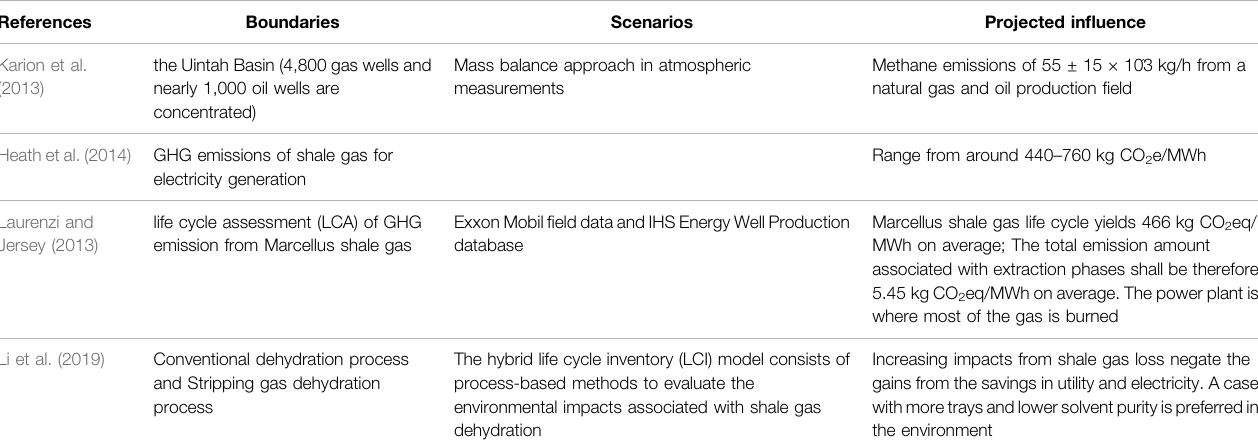
TABLE 2 | Most relevant studies on GHG emission on shale gas